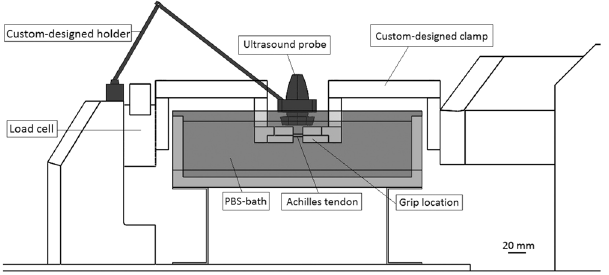
Figure 6. Experimental setup to measure biomechanics and echo intensity simultaneously. Bar = 20